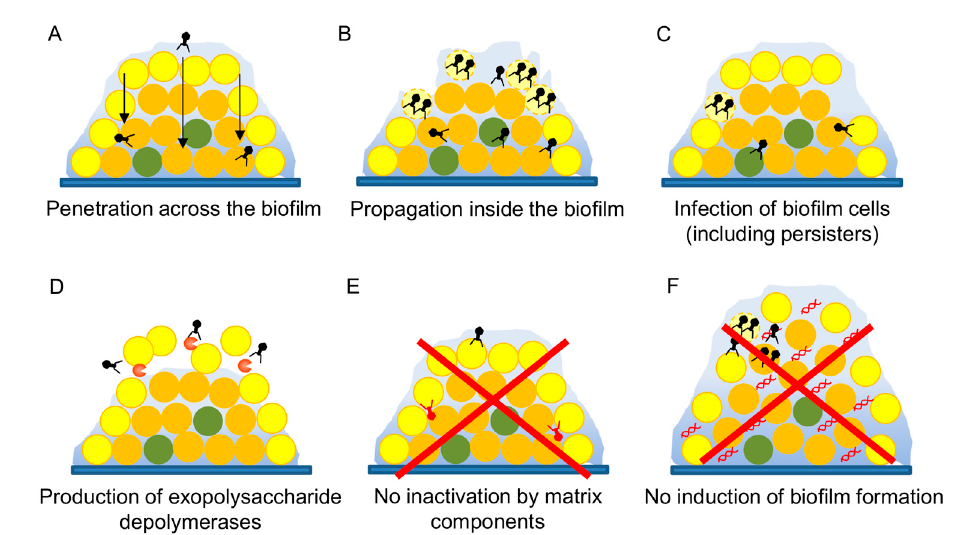
Figure 2. Analysis of the antibiofilm potential of a candidate bacteriophage.